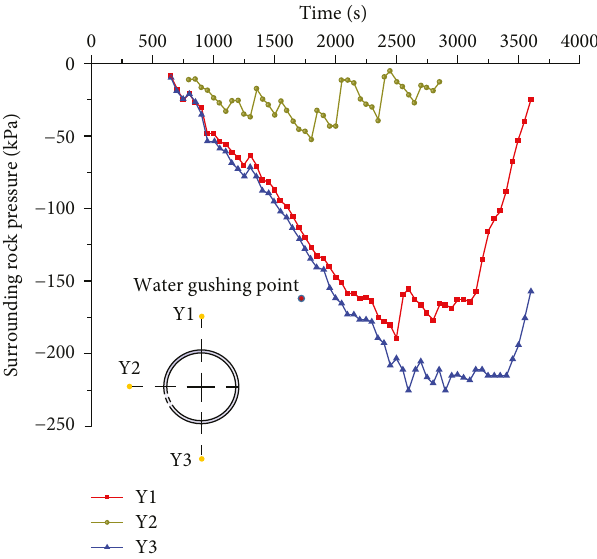
Figure 12: Surrounding rock pressure – time curves of Y1, Y2, and